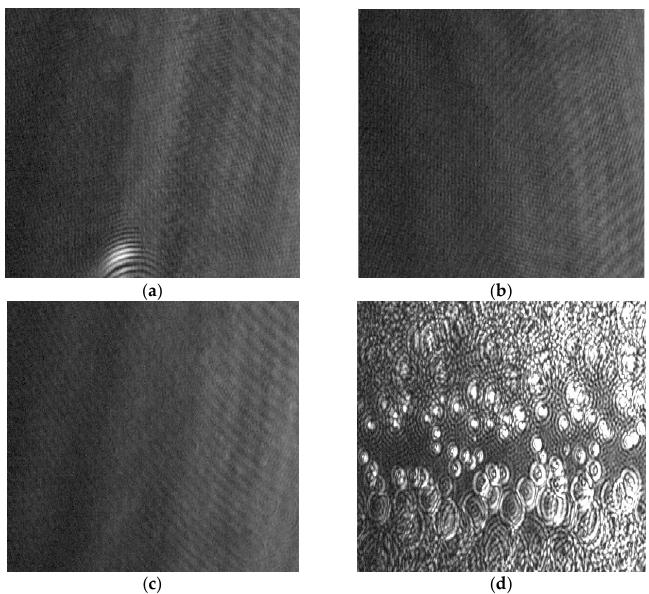
Figure 12. Brewster angle microscopy images of Me 4 -15 Langmuir layer surface obtained at com- pression up to the following values of surface pressure and area per a molecule: 0 mN m − 1 and 1890 Å 2 ( a ), 3.8 mN m − 1 and 1610 Å 2 ( b ), 7.5 mN m − 1 and 1030 Å 2 ( c ), 8.4 mN m − 1 and 490 Å 2 ( d ). Table 4. Characteristic points A–D of π -A and Δ U-A isotherms for Me 4 -15 , Ph 4 -15 , Ph r4 -15 , Tol 4 -15 .